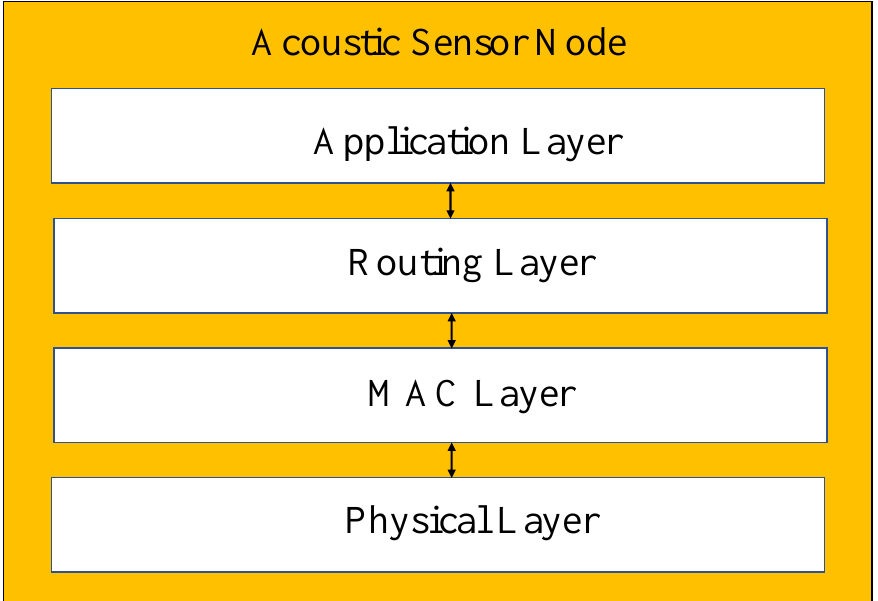
Figure 7. The programming structure of the sensor